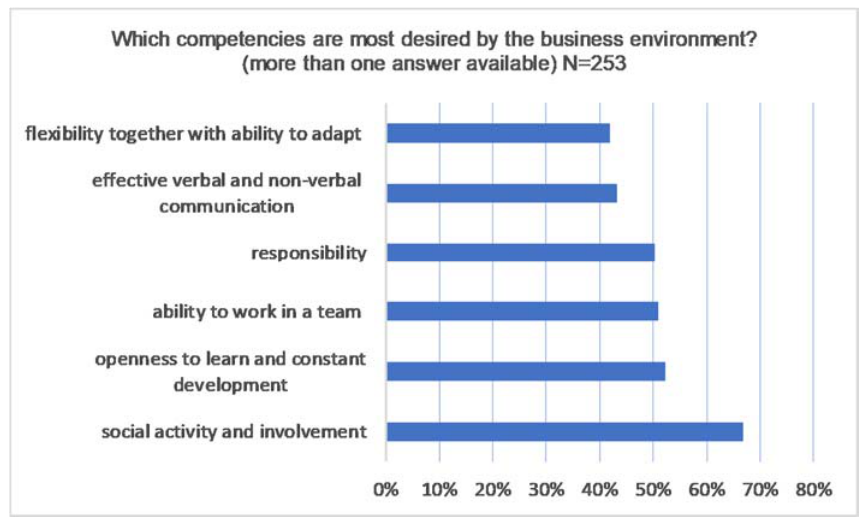
Figure 7. Most desired sustainability ‐ oriented competencies according to business environment.